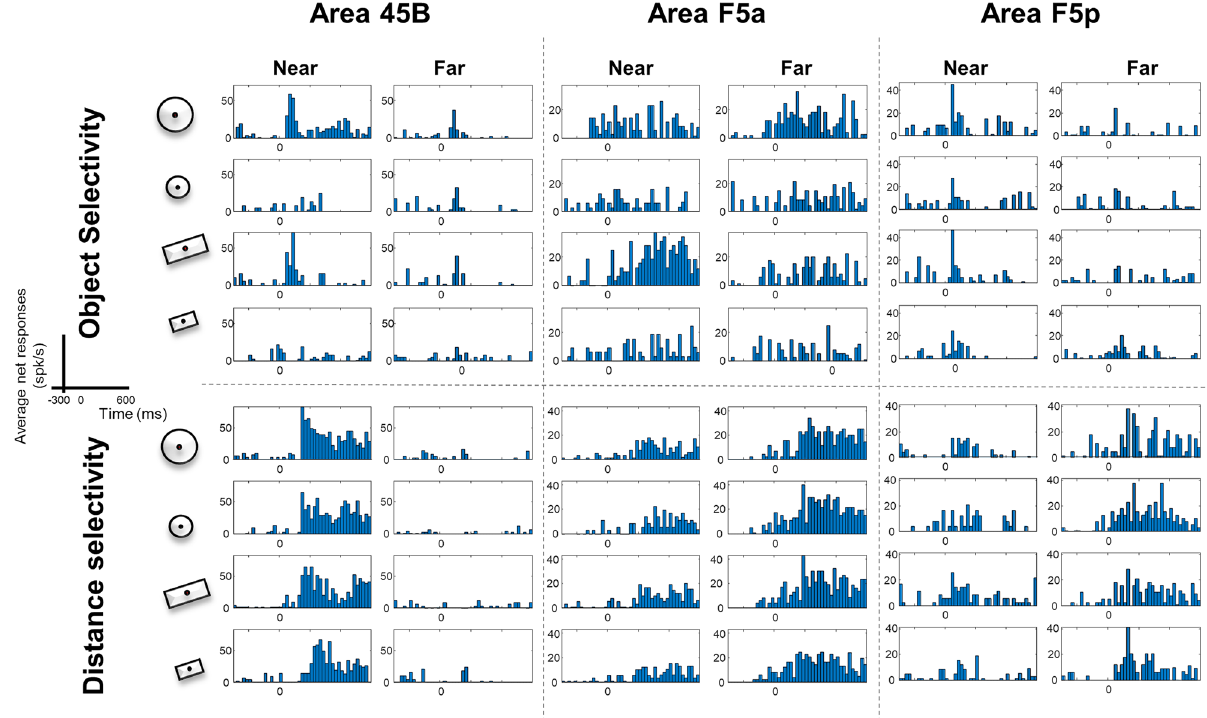
Figure 2. Example neurons in area 45B, F5a and F5p, from Monkey D and Y. In the upper panel, three neurons showing Object selectivity (from left to right, preference for large objects, large plate and large sphere, all from Monkey D except for F5a’s); in the lower panel, three example neurons of Distance selective neurons (from left to right, preference for Near, Far, Far, all from Monkey D). All example cells are separated by dashed lines. All neurons are aligned at light